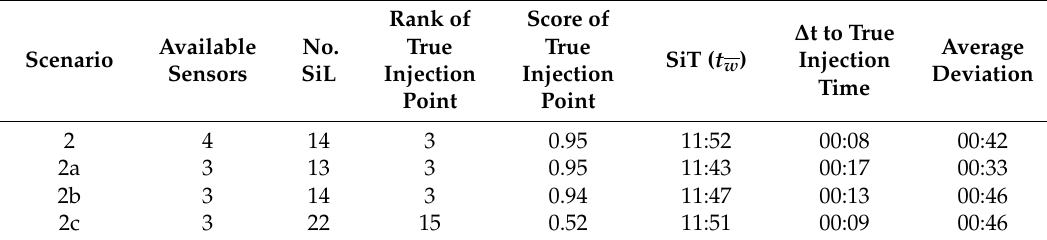
Figure 14. CPSITE simulation results: ( a ) Scenario 2, ( b ) Scenario 2a, ( c ) Scenario 2b, and ( d ) Scenario 2c. Table 11. Summary of scenario 2 and the sub-scenario